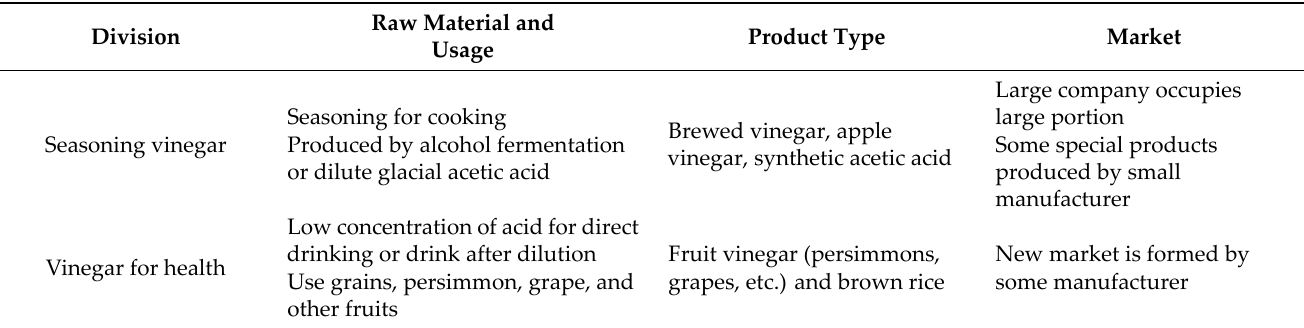
Table 3. Classification of vinegar by use and market